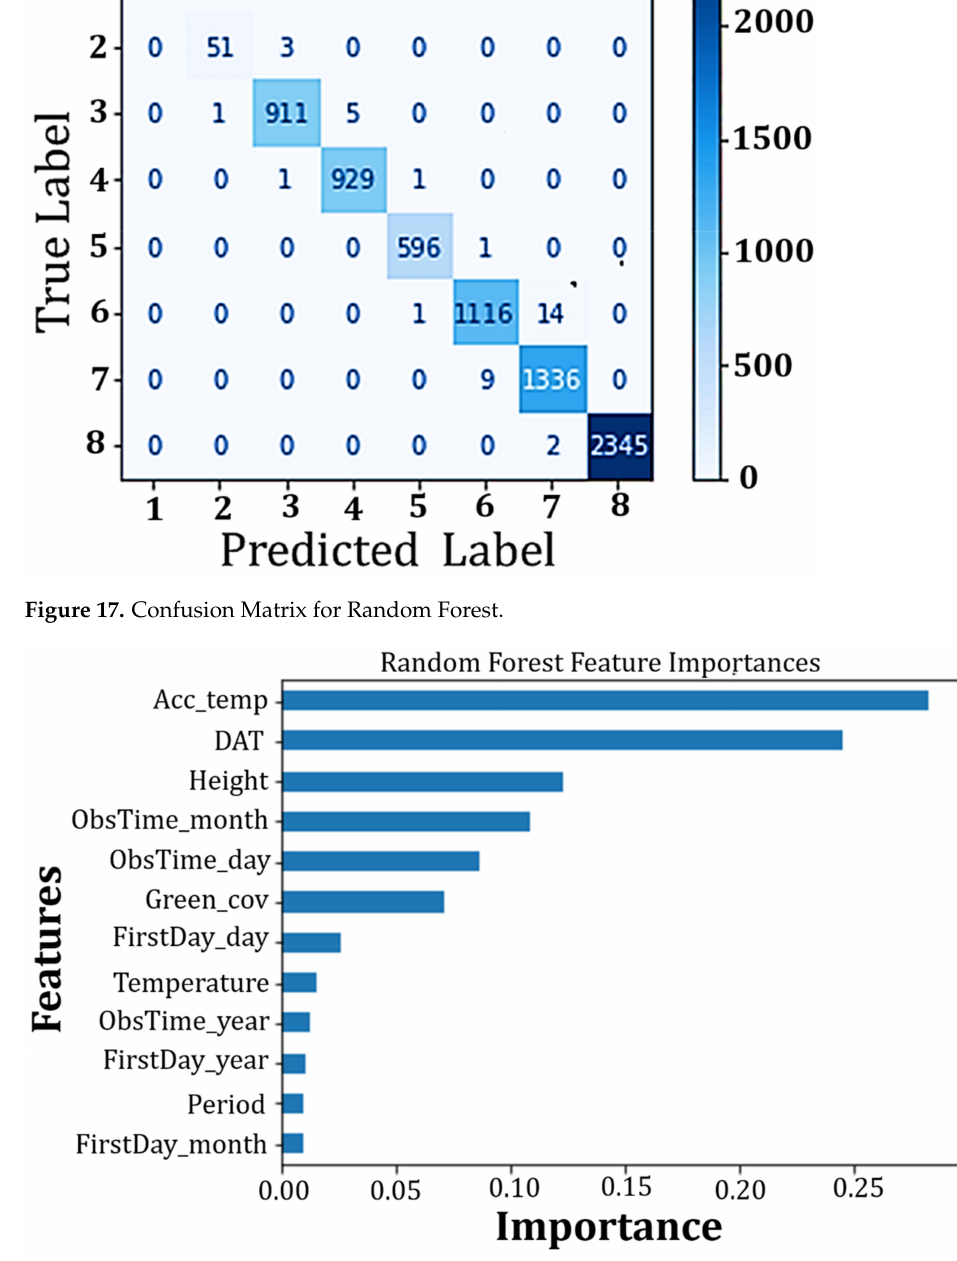
Figure 18. SHAP Library-The Feature Significance of the Proposed Model, Employing the RF. Table 13. Training Dataset Before and After Up-sampling